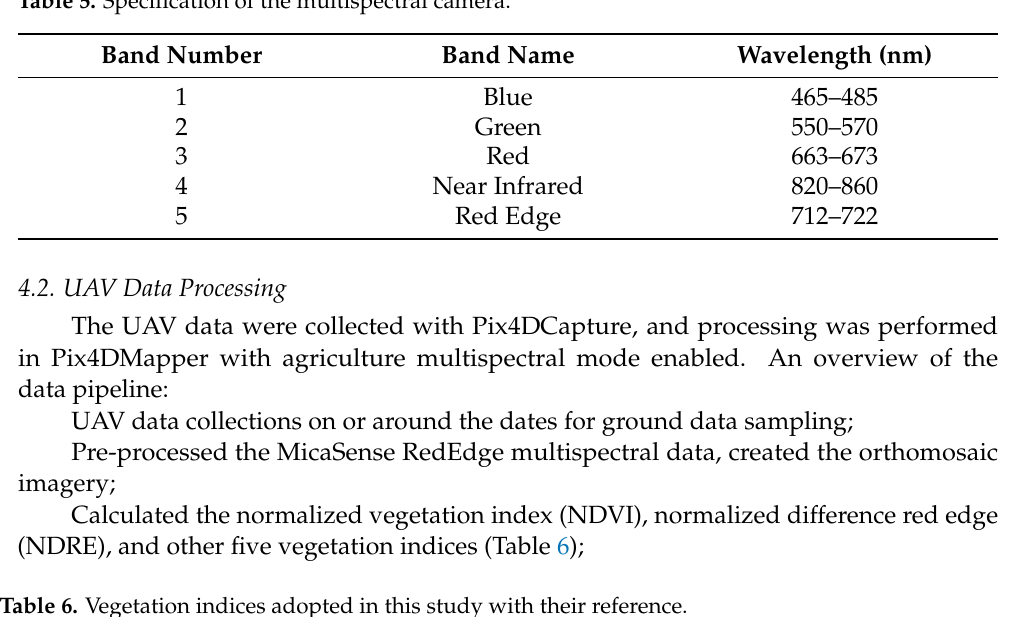
Table 5. Specification of the multispectral